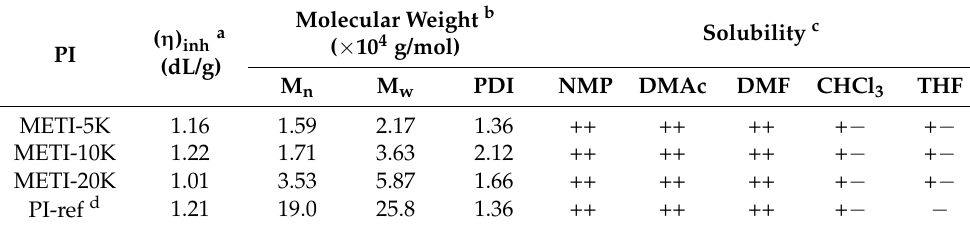
Table 2. Inherent viscosities, molecular weights, and solubility of METI and PI-ref resins.